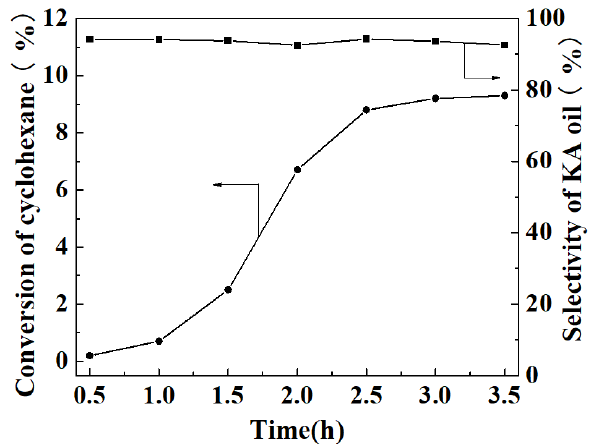
Figure5: Profile of the aerobic oxidation of cyclohexane catalyzed by C mimHSO -Co/ZSM-5 catalyst. Cyclohexane (0.1 mol), catalyst (6.0 7 4 wt%), O (1.5MPa), 150 o C. 2